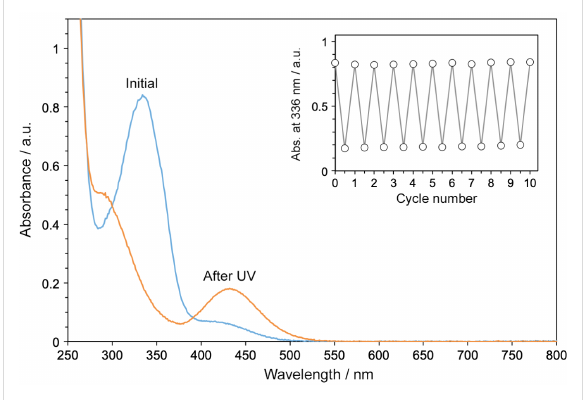
Figure 4: UV–vis absorption spectrum of an aqueous solution of ( E - 1 ) 2 2 (blue) and following exposure of this solution to UV light for 5 min (orange). Inset: Ten cycles of reversible E - 1 ⇌ Z - 1 photoisomer- ization. In each cycle, 5 min of UV was applied, followed by 2 min of green